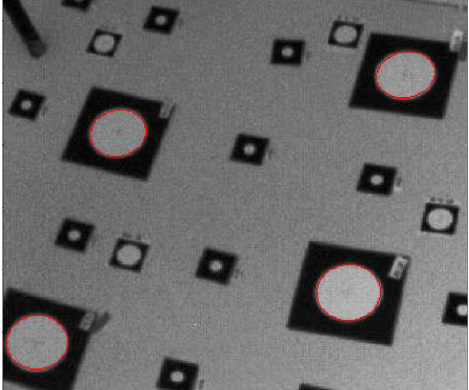
Figure 2. Ellipses fit to the